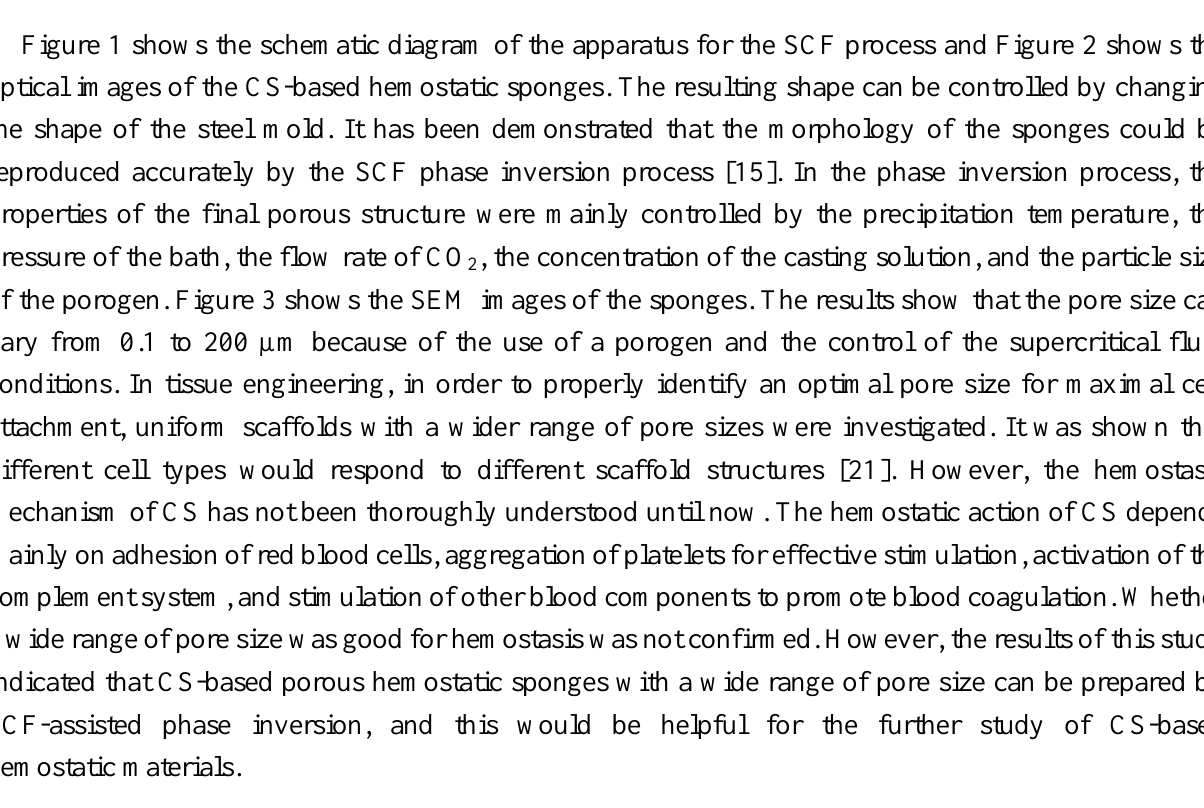
Figure 1. Schematic diagram of the apparatus for the supercritical fluid (SCF)